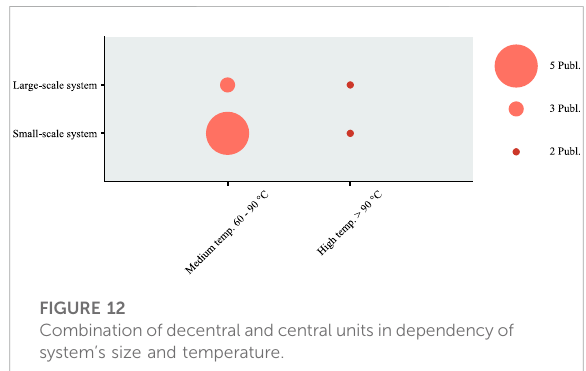
system ’ s size and